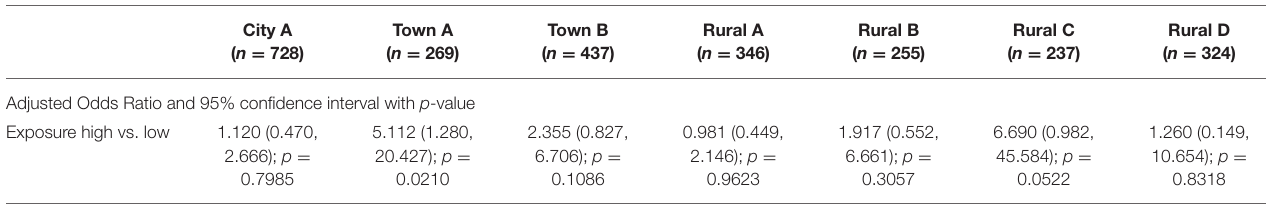
Change from obese to overweight/normal (pre-obese) BMI Town A ( n = 269)